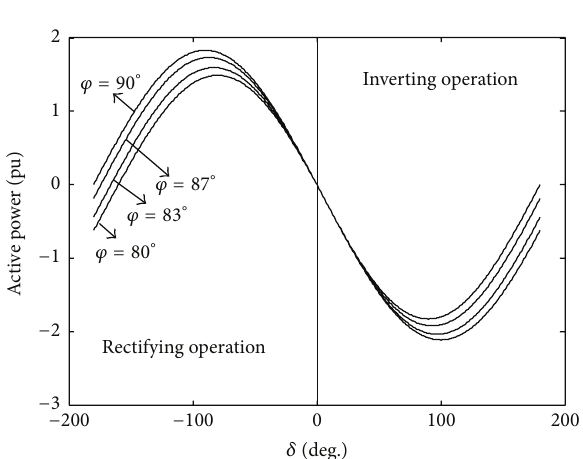
Figure 4: Power angle curves in different impedance